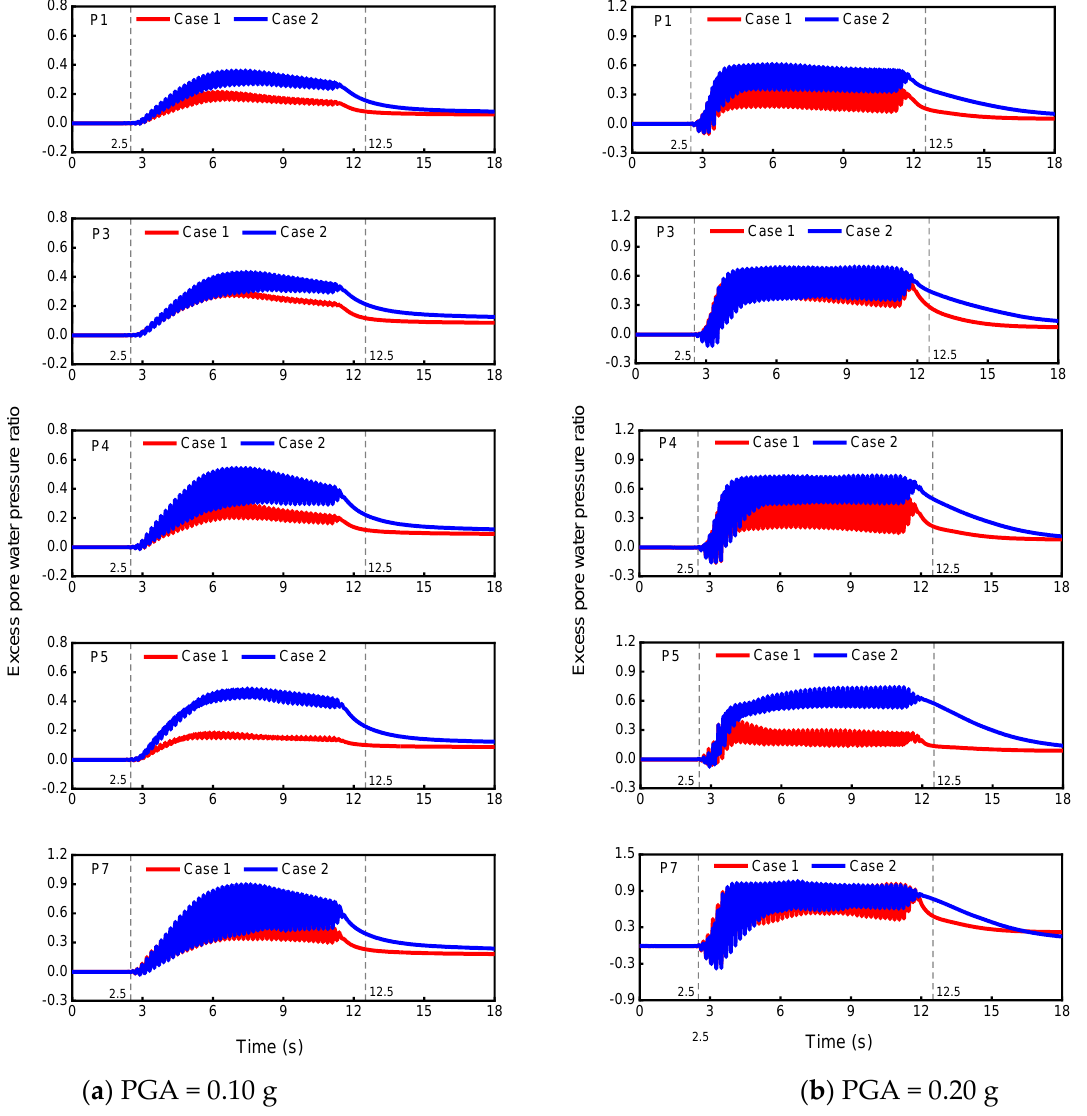
Figure 6. Time-history curve of excess pore water pressure ratio.